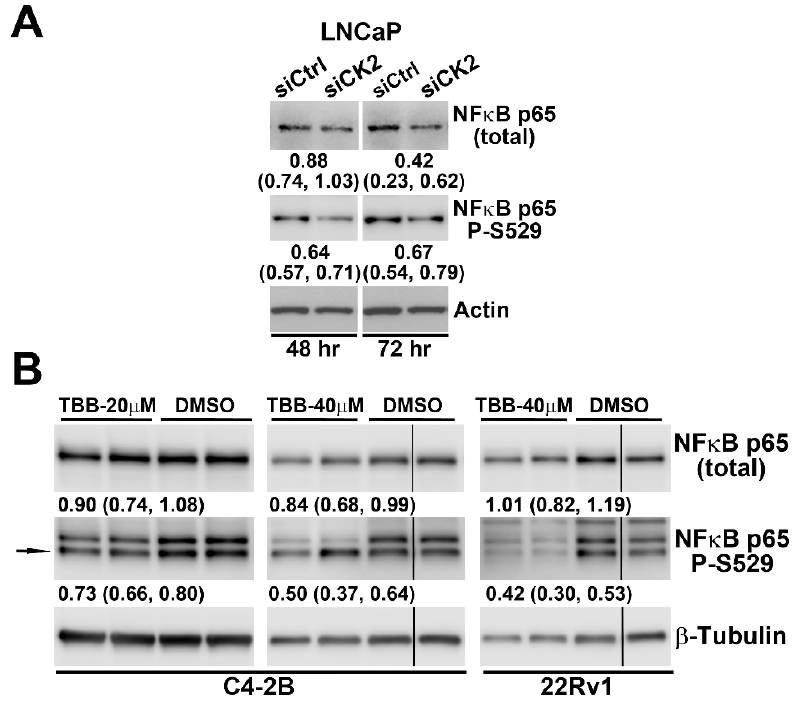
Figure 4. Blocking CK2 expression and activity reduces NF κ B p65 protein levels and activation in PCa cells. ( A ) LNCaP cells were transfected with CK2 αα ’-targeted and control siRNAs. Cells were collected 48 and 72 h post-transfection, as labeled below the blots, for analysis by immunoblot. ( B ) C4-2B and 22Rv1 cells were treated with 20 µ M TBB, 40 µ M TBB or equivalent concentration of DMSO as indicated. Cells were collected at 24 h for analysis by immunoblot. Vertical lines indicate non-contiguous lanes. For all panels: proteins detected are indicated on the right side of blots and either actin or β -tubulin were used as loading controls. Arrows indicate correct band. Means and 95% confidence intervals for values relative to siControl or DMSO are indicated below each blot.